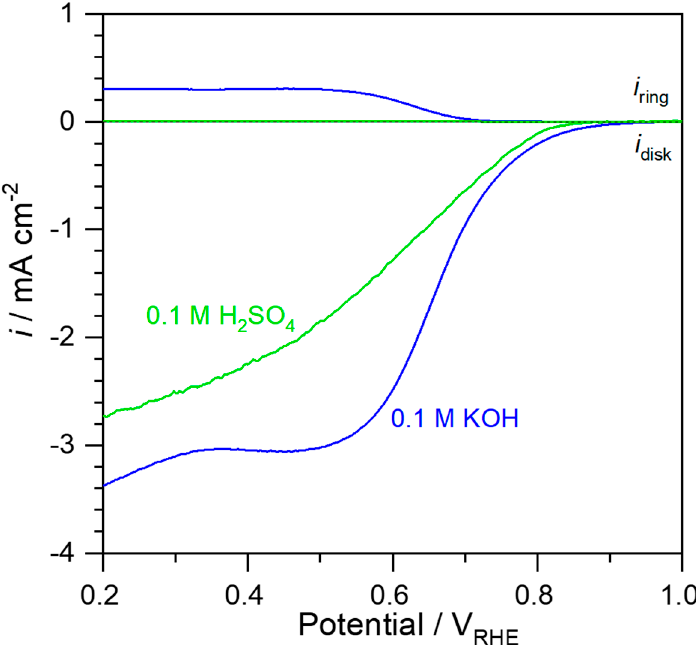
Figure 5. LSVs of the RRDE measurements for ORR over ultrafine TaO x /CB nanoparticles prepared by electrodeposition and subsequent annealing treatment in an H 2 flow in O 2 -purged 0.1 M KOH and 0.1 M H 2 SO 4 aqueous solutions at a revolution rate of 1600 rpm and a sweep rate of 5 mV s − 1 . A potential of 1.2 V RHE was applied to the Pt ring electrode.